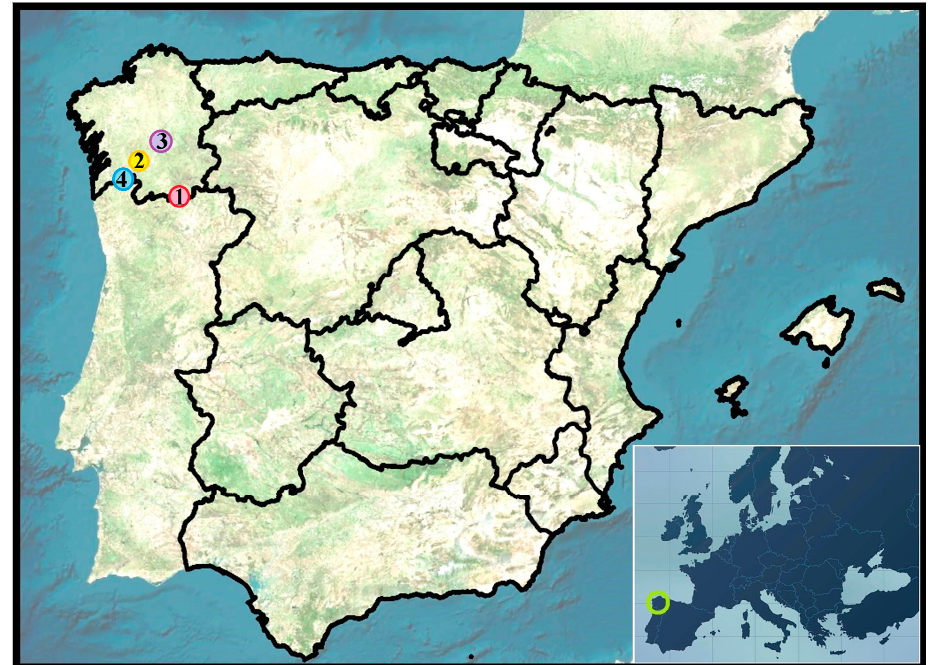
Figure 1. Location of the vineyards in Galicia (Spain). Climatic zones: Monterrei (1: point in red) zone II (indoor oceanic climate); Ribeira Sacra (3: point in purple) zone II-III (indoor—Mediterranean oceanic climate); Ribeiro (2: point in yellow) zone III (Mediterranean oceanic climate); R í as Baixas (4: point in blue) zone I (coastal oceanic climate). Bottom-right: green circle shows the location of Galicia region within Europe.